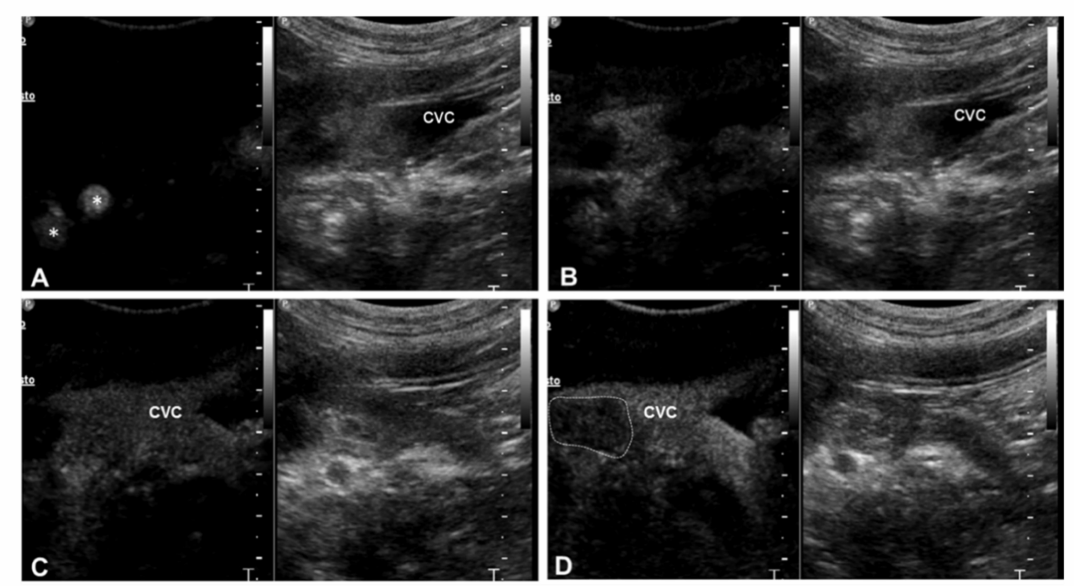
Figure 2. ( A – D ) Representative contrast-enhanced ultrasound sequences of malignant thrombosis involving the caudal vena cava in a dog with right adrenal carcinoma (case 3). Each sequence illustrates contrast enhancement on the left and the gray scale image on the right. ( A ) Left image shows the contrast medium in the celiac and mesenteric arteries (*) (Arterial phase). The grayscale image shows the thrombus in the vessel; ( B ) In the left image, a di ff use enhancement within the thrombus is seen, while caudal vena cava is still anechoic (Anticipated wash-in); ( C ) The contrast medium arrives in the lumen of the caudal vena cava and the thrombus is not detectable; ( D ) On the left image, the thrombus shows wash out (dotted lines) while the contrast medium is still present on the lumen of the caudal vena cava